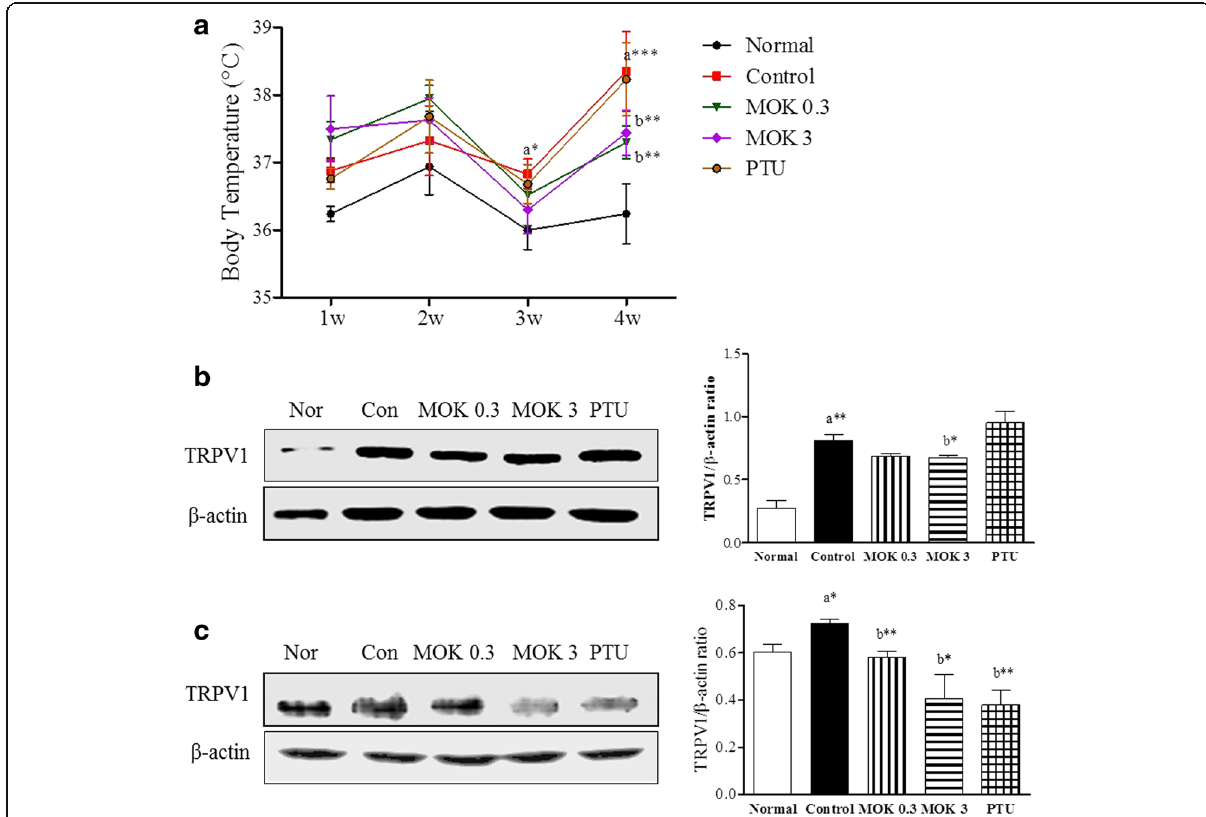
Fig. 4 Effect of MOK pharmacopuncture on the changes pharmacopuncture on the changes of body temperature and the expression of TRPV1 protein in LT4-induced hyperthyroidism rats. MOK pharmacopuncture was subcutaneously administered once daily for 2 weeks and the body temperature was measured by rectal thermometer ( a ) once a week. The production of TRPV1 protein was determined in DRG ( b ) and brain ( c ) tissues isolated from LT4-induced hyperthyroidism rats using Western blot. Data are presented as mean ± SD ( n = 5 per each group). * P < 0.05, ** P < 0.01 and *** P < 0.001 vs normal ( a ) or control ( b ). Normal, normal group; Control, LT4-induced hyperthyroidism group; MOK 0.3, MOK 0.3 mg/kg-treated group in control; MOK 3, MOK 3 mg/kg-treated group in control; and PTU, PTU 10 mg/kg-treated group as a reference drug